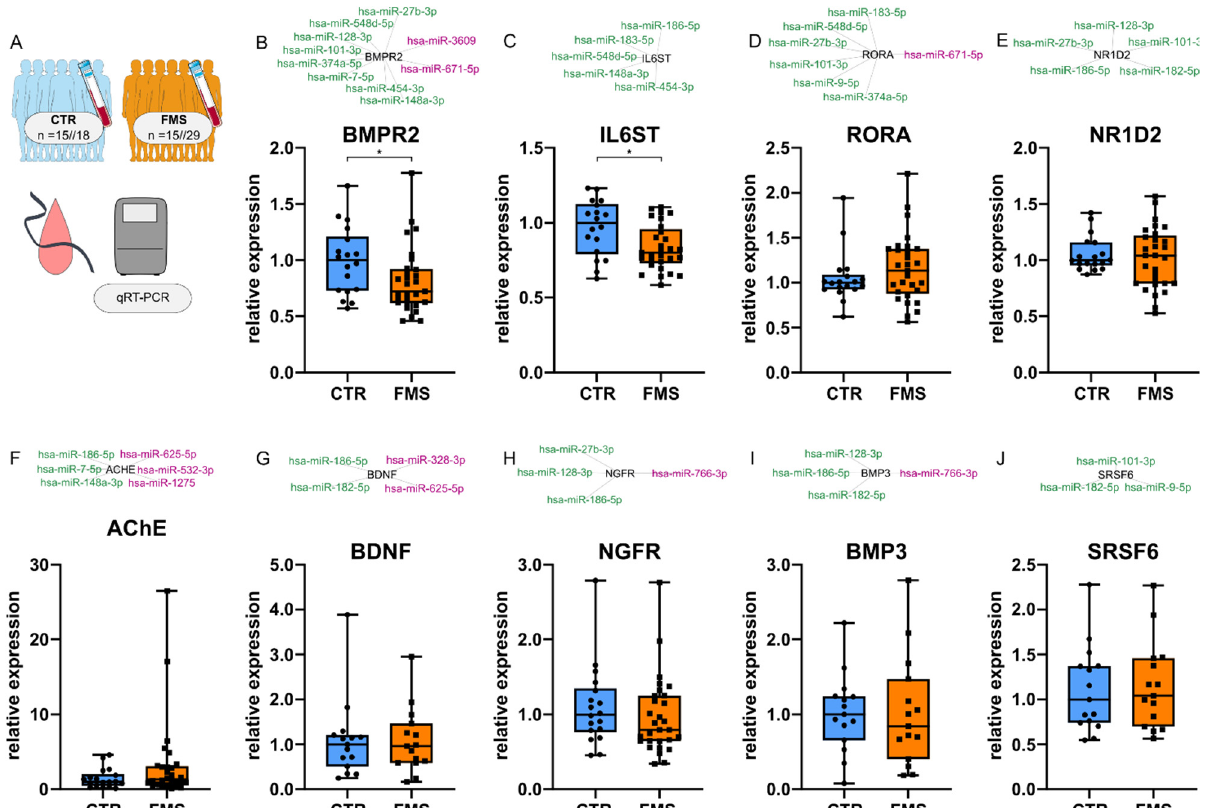
Figure 7. Transcript levels of related cholinergic mRNAs. ( A ) Workflow illustrates cohorts investigated. Global expression of two highly targeted transcripts BMPR2 ( B ) and IL6ST ( C ) was downregulated by 27.8% (* p = 0.025) and 19.9% (* p = 0.022), whereas RORA ( D ) and NR1D2 ( E ) were not altered in whole blood. ACHE ( F ) and BDNF ( G ), targeted equally by up- and down-regulated CholinomiRs, showed no altered expression, also seen in cholinergic transcripts NGFR ( H ), BMP3 ( I ), and SRSF6 ( J ), which were associated with fewer CholinomiRs. Randomly selected cohort subgroups with n = 29 FMS versus n = 18 CTR ( B – F , H ) or n = 15 FMS versus n = 15 CTR ( G , I , J ) were analyzed. Box and whisker plots with min to max. Mann–Whitney U test. Green color depicts upregulated miRs, whereas magenta labels depict downregulated miRs connected to the corresponding mRNA transcript in black.